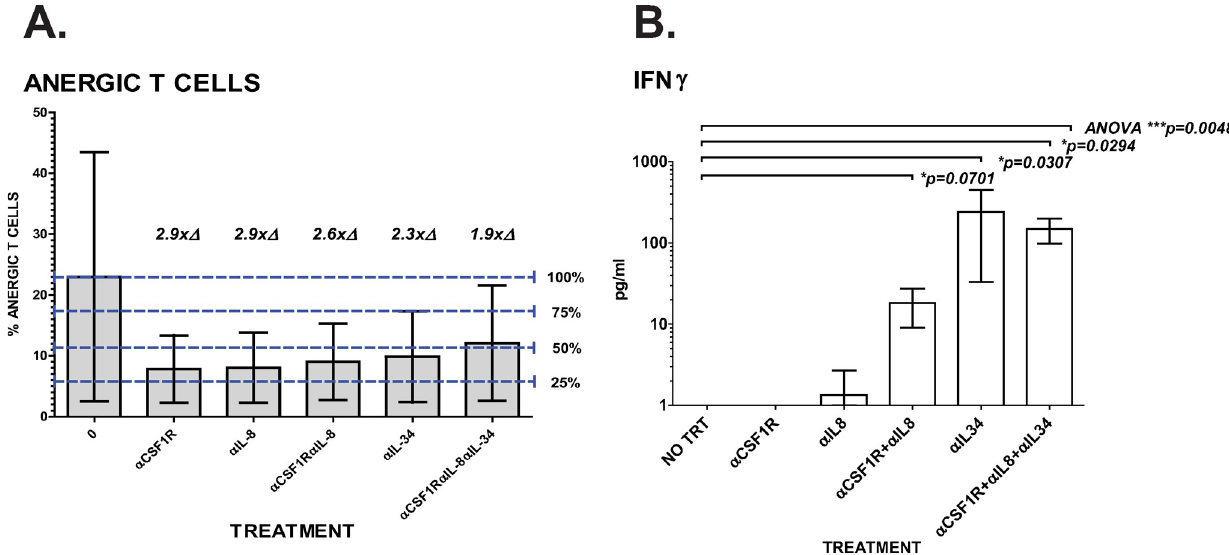
Fig 8. Inhibition of CSF1R, IL-8, and IL-34 reduces T cell anergy in PortalBMC ex vivo cultures. PortalBMC from 4 PDAC patients were cultured unsorted for 7 days at 37˚C/5%CO 2 in rich media with or without ( NO TRT ) supplementation with 4mg/kg humanized anti-CSF1R (BMS-986227, Cabiralizumab), 10mg/kg humanized anti-IL-8 (BMS-986253), and/or 4mg/kg anti-IL-34 (Abcam). After incubation, cells were collected and analyzed for identification of T cell subpopulations by flow cytometry and culture supernatant conditioned media were analyzed in duplicate by ELISA for comparison of IFN γ levels relative to untreated PortalBMC cultures. ( A ) Though the limited sample number precluded analysis of statistical significance, a strong trend for decreasing T cell anergy with antibody treatments was seen. Analysis of anergic T cells (CD25+CTLA4+PDL1+PD1+CD45+CD3+) in 7-day ex vivo PortalBMC cultures showed a 2-3-fold reduction of anergy among T cells in PortalBMC cultures treated with anti-CSF1R, anti-IL-8, and/or anti-IL34 alone or in combination. ( B ) Conditioned media from 6 PDAC patients’ 7-day ex vivo PortalBMC cultures without treatment showed no detectable IFN γ , suggestive of a lack of activated, non-anergic T cells present. Portal plasma from these 4 PDAC patients as well as 4 others also had no detectable IFN γ ( Fig 2C ). In contrast, peripheral blood plasma samples from the same 8 PDAC patients had detectable IFN γ levels comparable to healthy controls ( Fig 2C ). Treatment of 4 PDAC PortalBMC cultures with humanized anti-CSF1R or humanized anti-IL-8 alone did not significantly increase IFN γ production, but treatment with the combination of 4mg/kg anti-CSF1R and 10mg/kg anti-IL-8 increased IFN γ concentration in the conditioned media ( B ), though statistical significance was not achieved. The treatment of cultures with 4mg/kg anti-IL34 alone or in combination with anti-CSF1R and anti-IL-8 showed significantly enhanced IFN γ levels ( B , p = 0.0307 and p = 0.0294, respectively), suggestive of possible increased T cell activation within the cultures. Bars depict mean of values and error bars indicate standard error from the